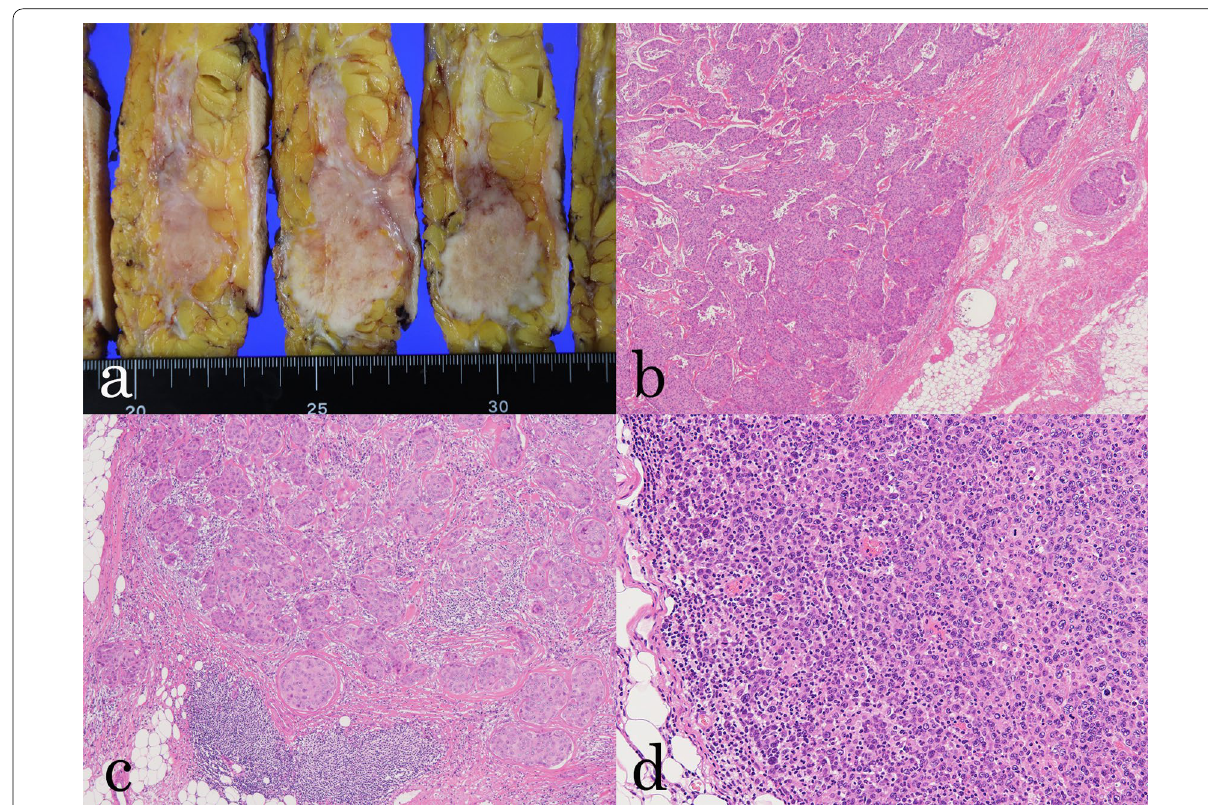
Fig. 4 Macroscopic and microscopic findings of the resected specimen. a Surgical specimen of the right breast. b Pathological examination of a specimen from the breast showed invasive carcinoma ( 4 magnification). c Pathological examination of the right axillary lymph node showed × metastatic cells from the breast cancer ( 10 magnification). d Pathological examination of the left axillary lymph node showed diffuse large B-cell × lymphoma